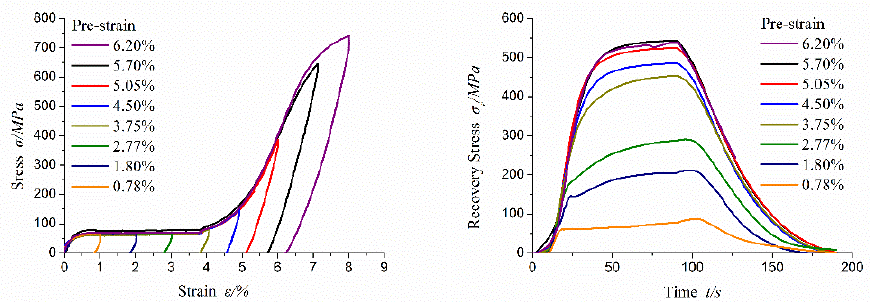
Figure 5. Recovery strain and recovery stress test results.